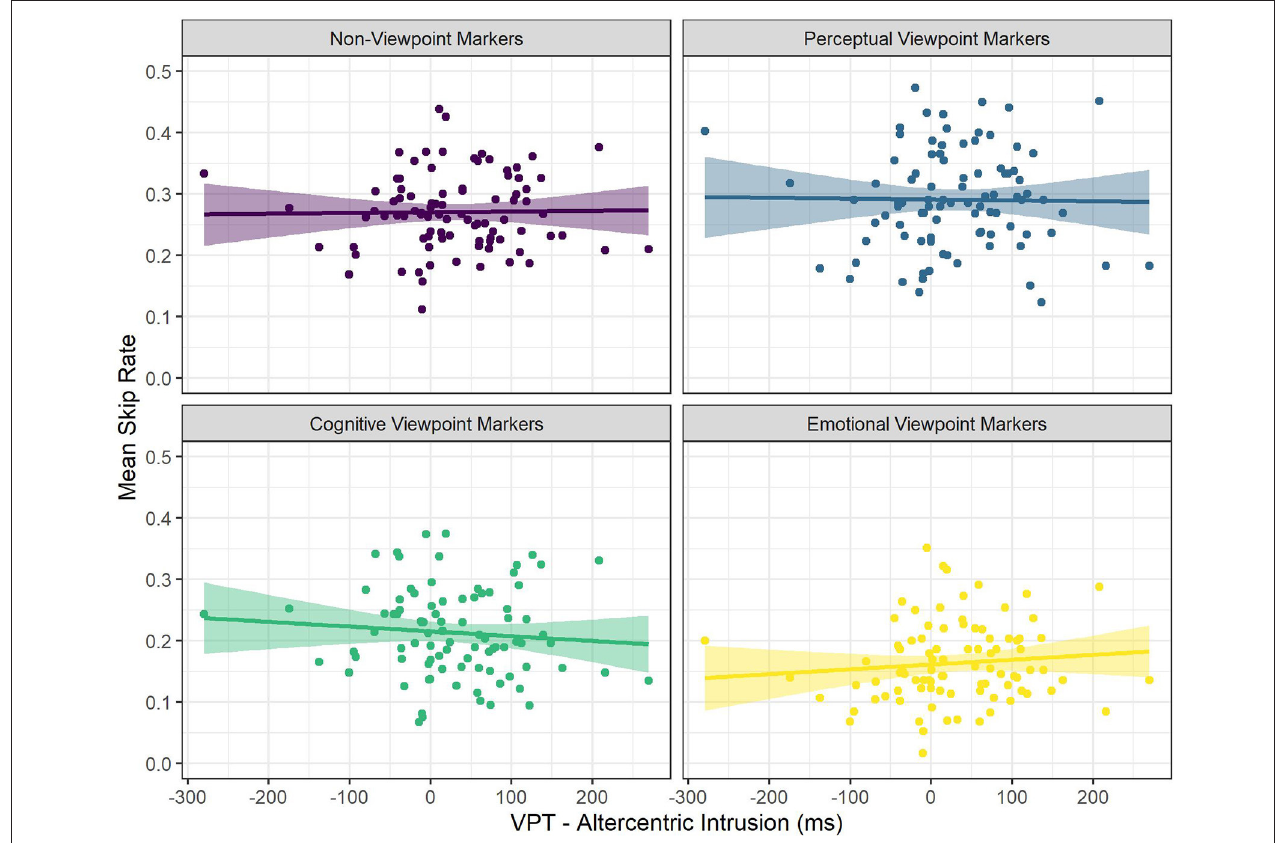
FIGURE 3 | The Relationship Between Mean Skip Rate and Altercentric Intrusion for the Different Categories of Viewpoint Markers. Each Dot Represents a Participant.